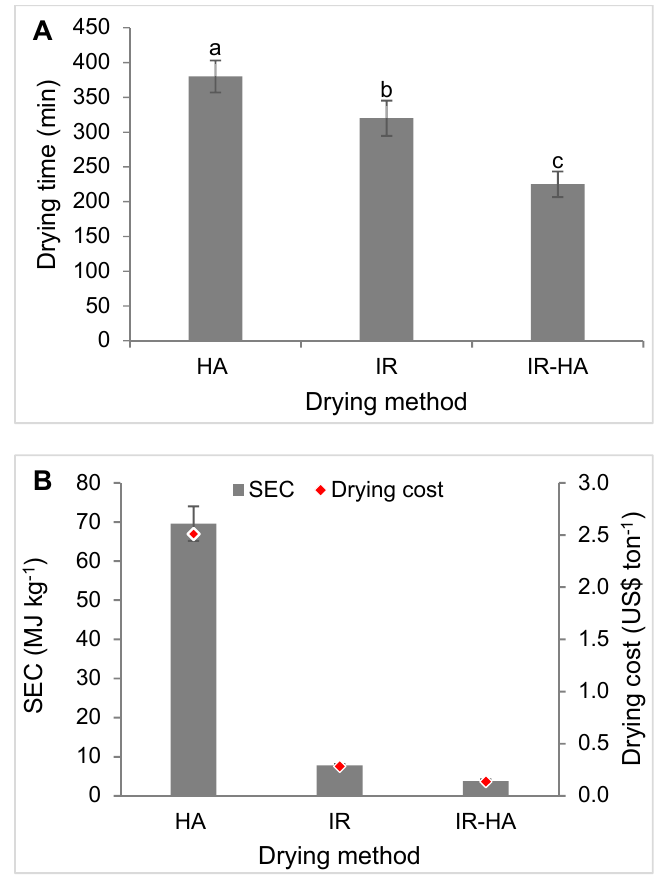
Figure 7. The minimum drying time ( A ) and corresponding specific energy consumption (SEC, B ) recorded using different studied drying systems; hot air convection drying (HA) at 60 °C and 1.0 m/s, infrared radiation drying (IR) at 0.3 W/cm 2 , and 0.5 m/s and combined infrared-hot air convection (IR-HA) at 60 °C, 0.3 W/cm 2 , and 0.5 m/s. The columns with the same letter showed insignificant differences (at P ≤ 0.05).